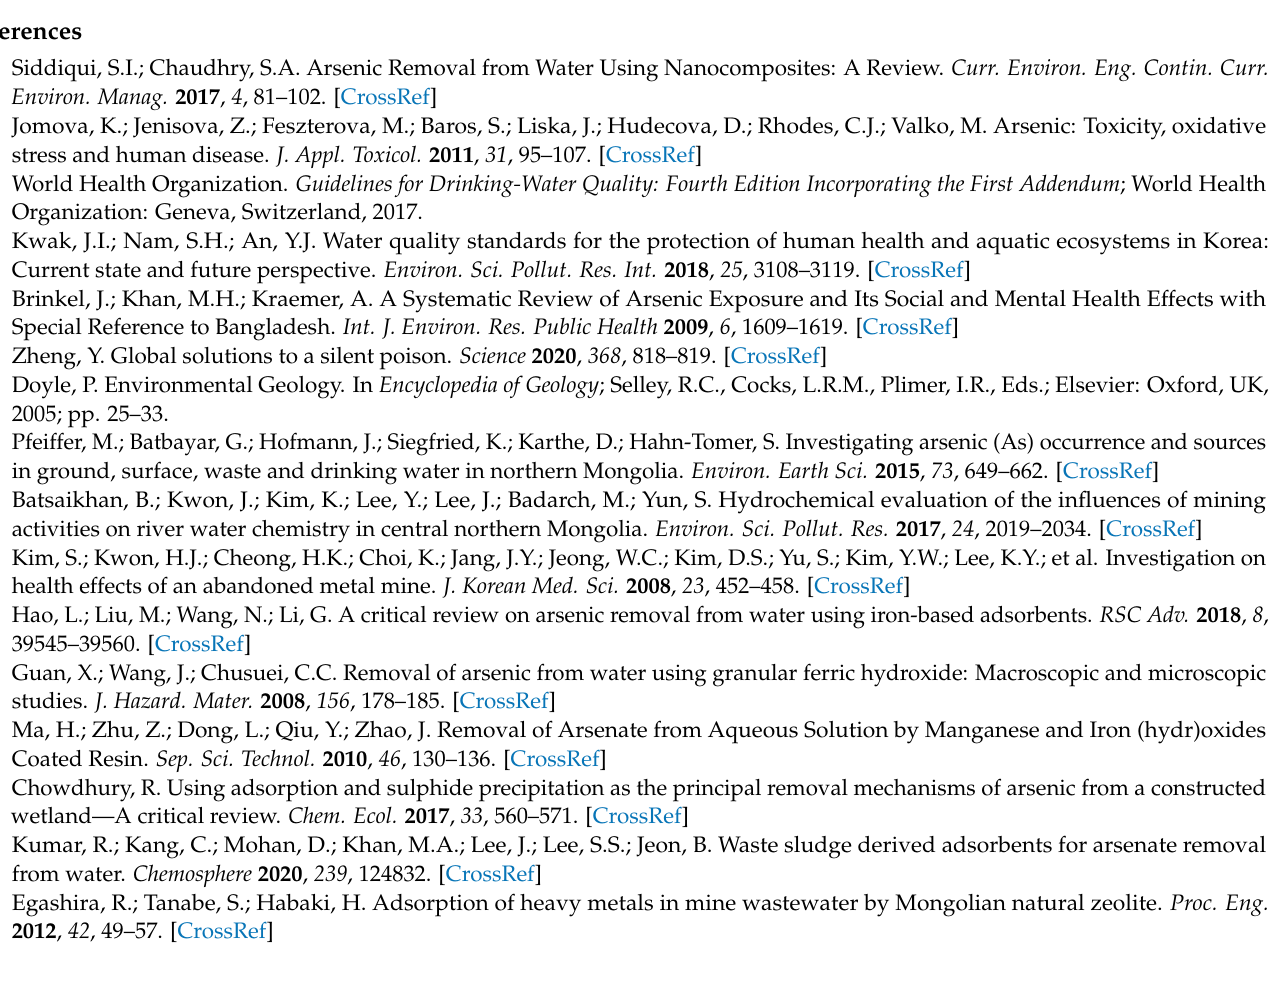
Figure S4: SEM/EDS images of (a) fresh and (b) spent GFH, Figure S5: SEM/EDS images of (a) fresh and (b) spent MIRESORB TM